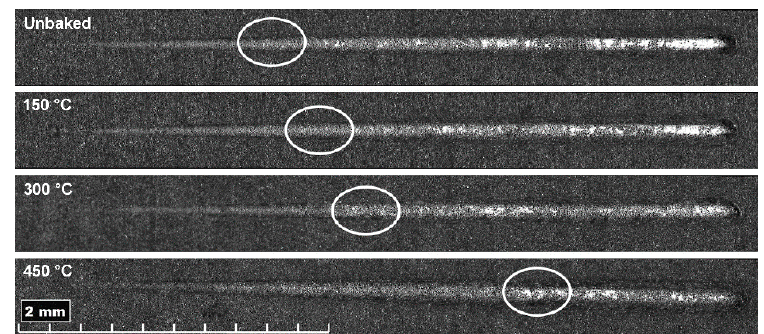
Figure 10. Scratch test trails with the coating detachment highlighted in the white circles.